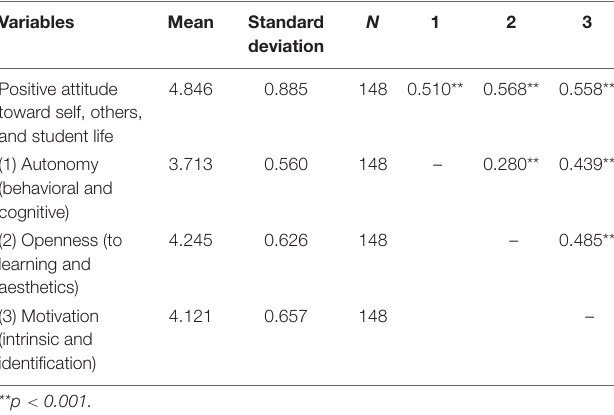
TABLE 3 | Descriptive statistics and correlation matrix for research model variables.